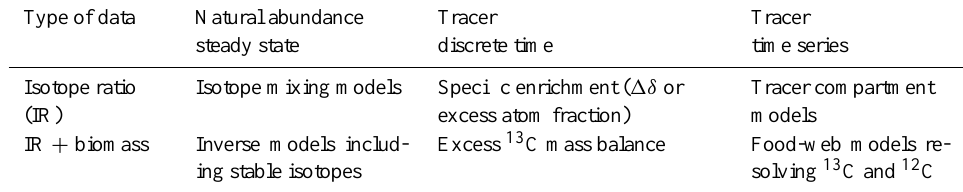
Table 2. Overview of approaches to analyze stable isotope